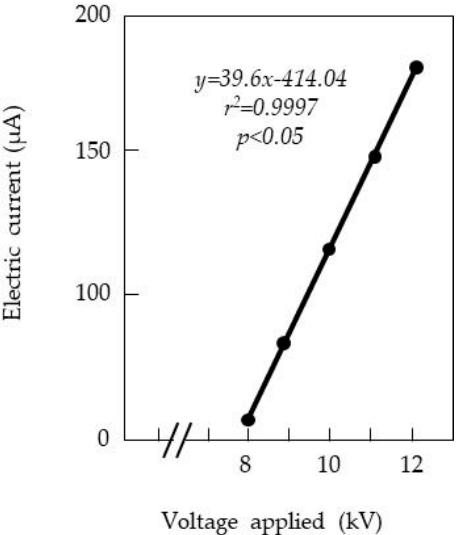
Figure 3. Relationship between voltage applied to the insulated plate and current magnitude produced through corona discharge in the electric field of the SEP.